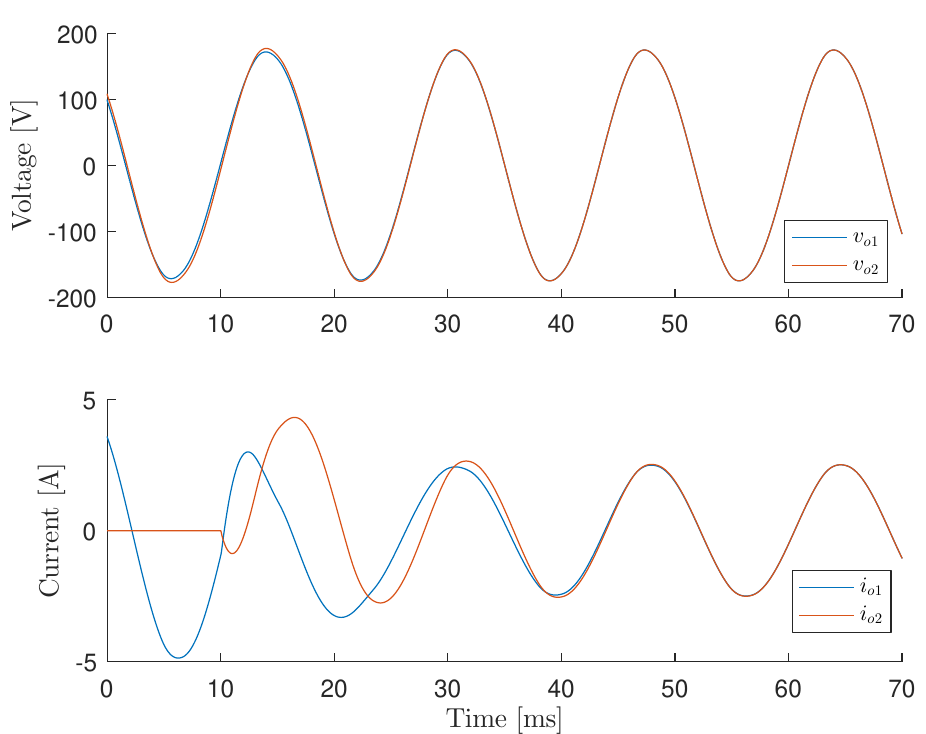
Figure 7. Synchronization of two oscillators designed with PM without pre-synchronization. For a more detailed analysis, the graph of Figure 8 was constructed, where the differ- ence between the output voltages and output currents for each method is compared.